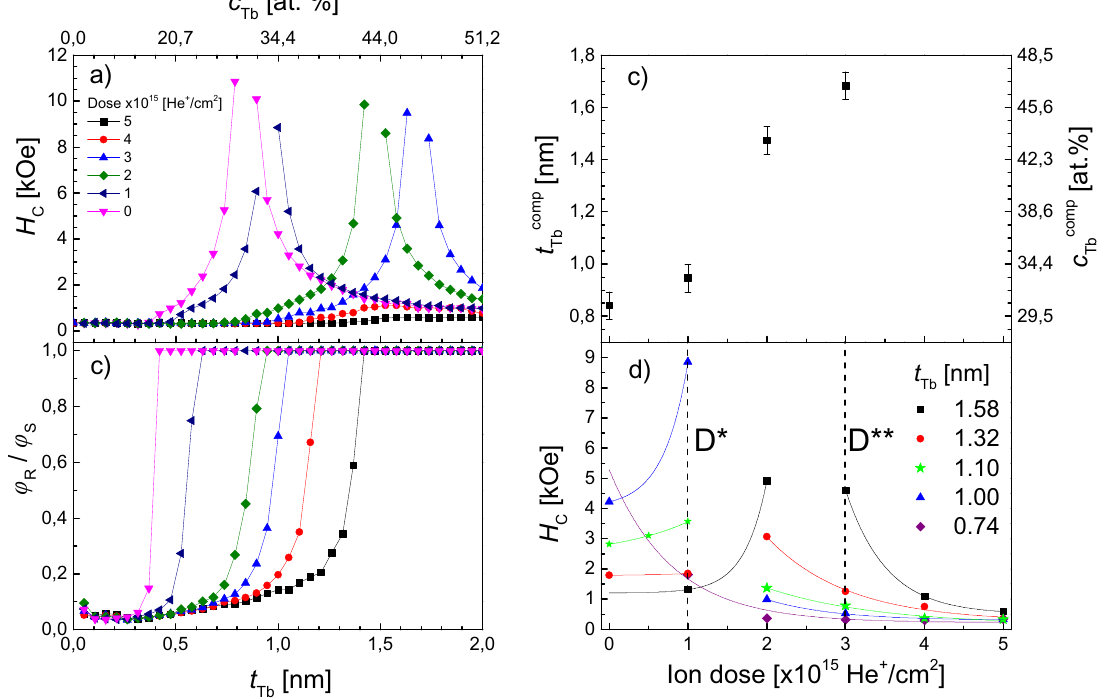
Figure 1. ( a ) H C dependence on Tb sublayer thickness ( t Tb ) and on average Tb concentration ( c Tb ) for the wedged sample A for five different doses, D , of 10 keV He + ions, ( b ) ratio between remanence and saturation Kerr signals ( φ R / φ S ) versus t Tb ( c Tb ), ( c ) Tb sublayer thickness and Tb concentration at the compensation point t Tb comp and c Tb comp as a function of D , ( d ) H C ( D ) for various t Tb values. D * = 1 × 10 15 He + /cm 2 and D ** = 3 × 10 15 He + /cm 2 indicate doses used in the ion beam patterning experiment described further below.